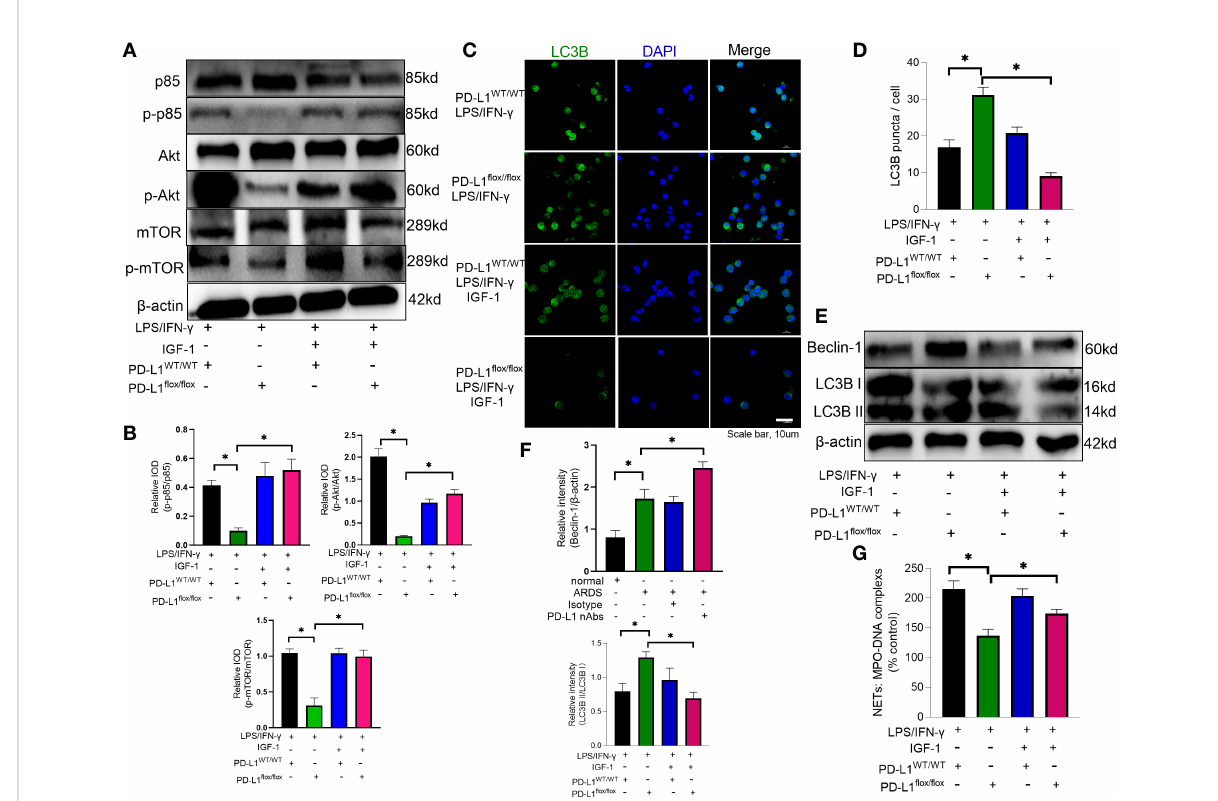
FIGURE 6 IGF-1 is able to counteract the protective effect of PD-L1 knockdown by activating the PI3K/Akt/mTOR pathway. (A – G) Neutrophils from PD- L1 WT/WT mice or PD-L1 fl ox/ fl ox mice stimulated with IFN-g (10ng/ml) and LPS (1mg/ml) are treated with IGF-1 (10ng/ml) or DMSO for 21h. (A) IGF-1 can activate the PI3K/Akt/mTOR pathway con fi rmed by Protein levels of p85, p-p85, Akt, p-Akt, mTOR, p-mTOR in neutrophils. (B) Integrated optical density ratio of p-p85/p85, p-Akt/Akt, P-mTOR/mTOR. (C) Autophagy induction assessed with LC3B staining (confocal microscopy; green: LC3B; blue: DNA) in neutrophils (scale bar: 10um). (D) LC3B puncta/cell are depicted. (E) PD-L1, Beclin-1 and LC3B II/I immunoblotting in neutrophils. (F) Integrated optical density ratio of LC3B II/LC3B I. (G) MPO-DNA complex measured in NETs structures in neutrophils culture supernatant. The values presented are mean ± SEM (n=6; *P<0.05, one-way analysis of